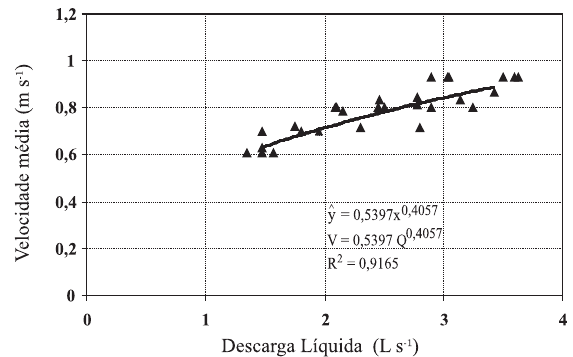
figura)Figura 2. Relação entre a velocidade média do escoamento (V) e as crescentes descargas líquidas (Q).